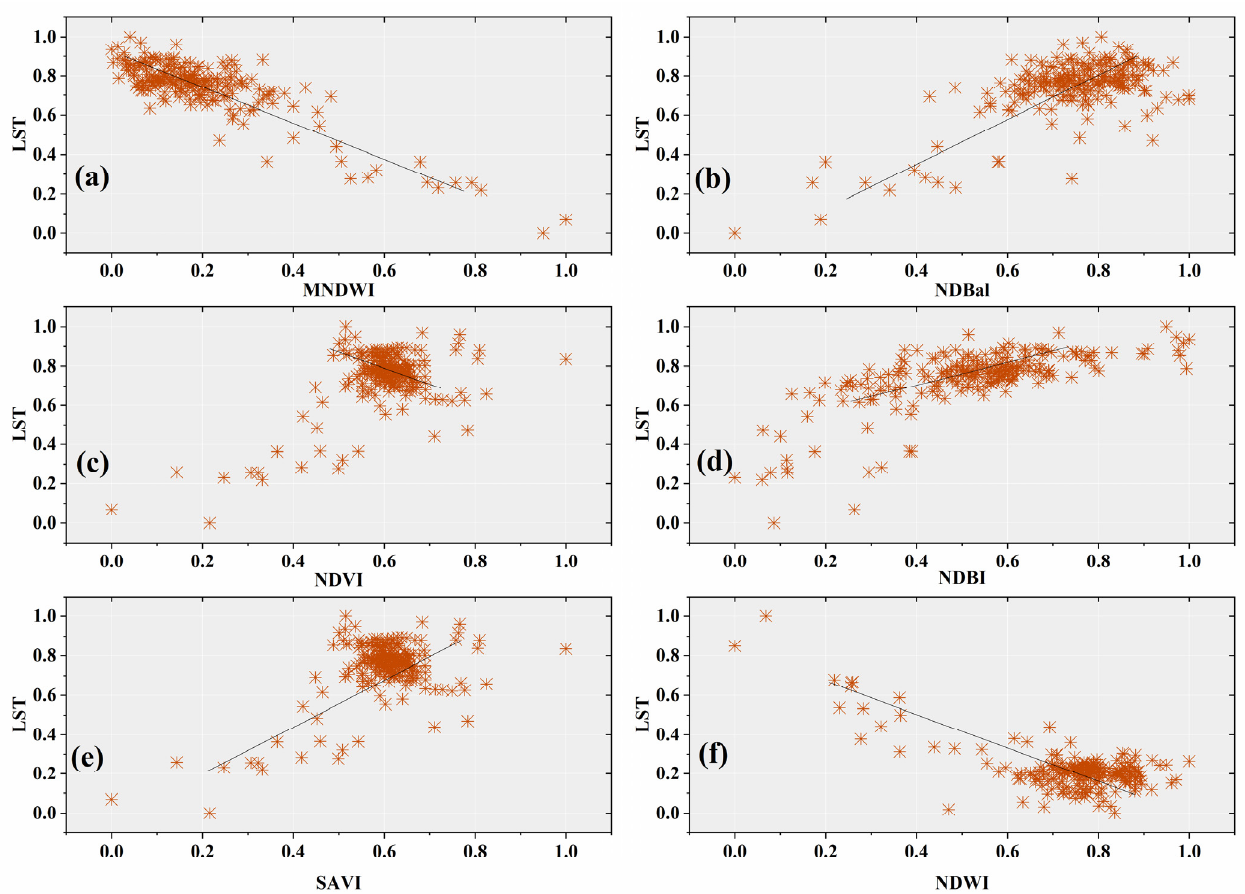
Figure 5. Scatter plots showing the relationship between LST and biophysical indices (2021) ( a ) MNDWI ( b ) NDBaI ( c ) NDVI ( d ) NDBI ( e ) SAVI ( f )